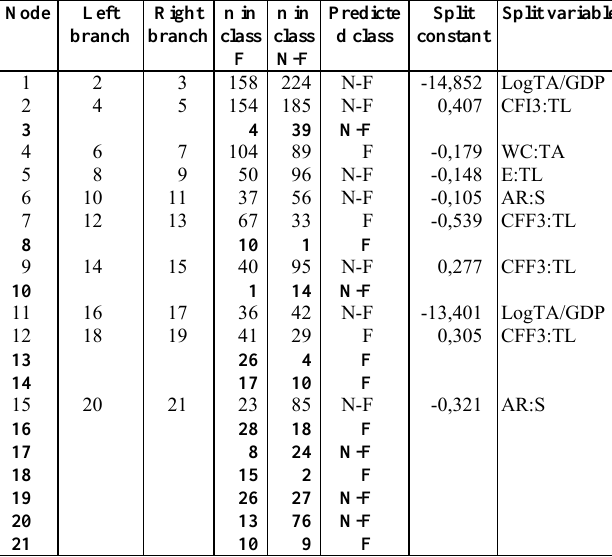
Figure 2: Recession model classification tree Table 9: Classification tree structure for recession model Table 10: Test sample misclassification matrix for recession